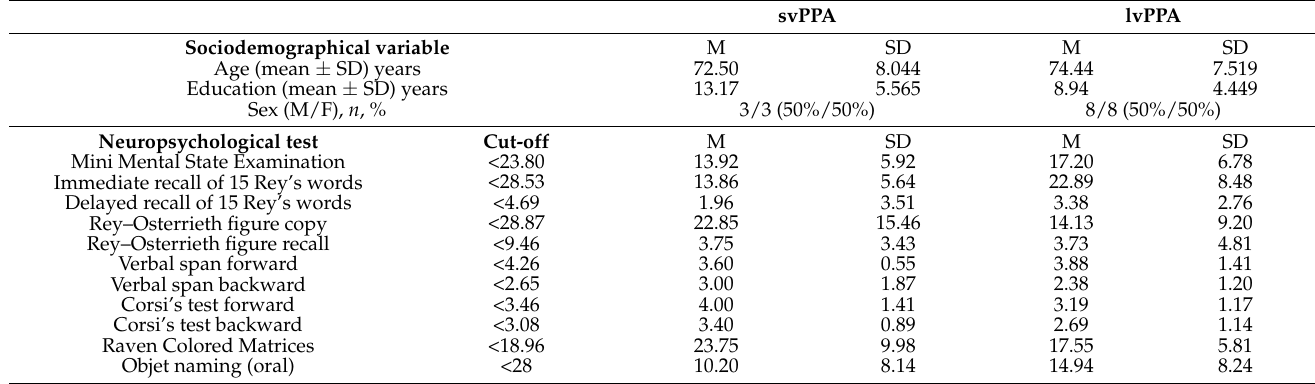
Table 1. Sociodemographic characteristics and neuropsychological assessment of the two clinical groups.